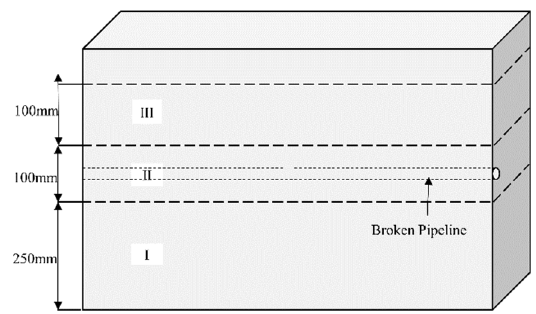
Figure 4. Model filling division.